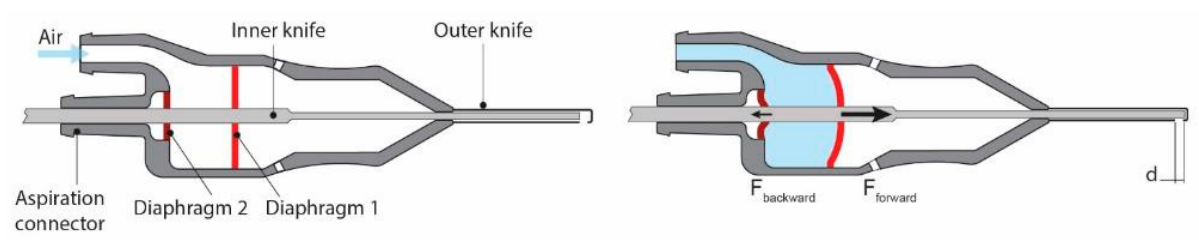
Figure 4. Working principle of the dual diaphragm mechanism. Left: schematic dual diaphragm design showing the various components of the design before air pressure is applied. Right: air pressure is applied to the chamber, causing both diaphragms to exert an opposite force on the inner knife. The larger diameter of Diaphragm 1 results in a net forward force, causing a displacement “d” of the inner knife.